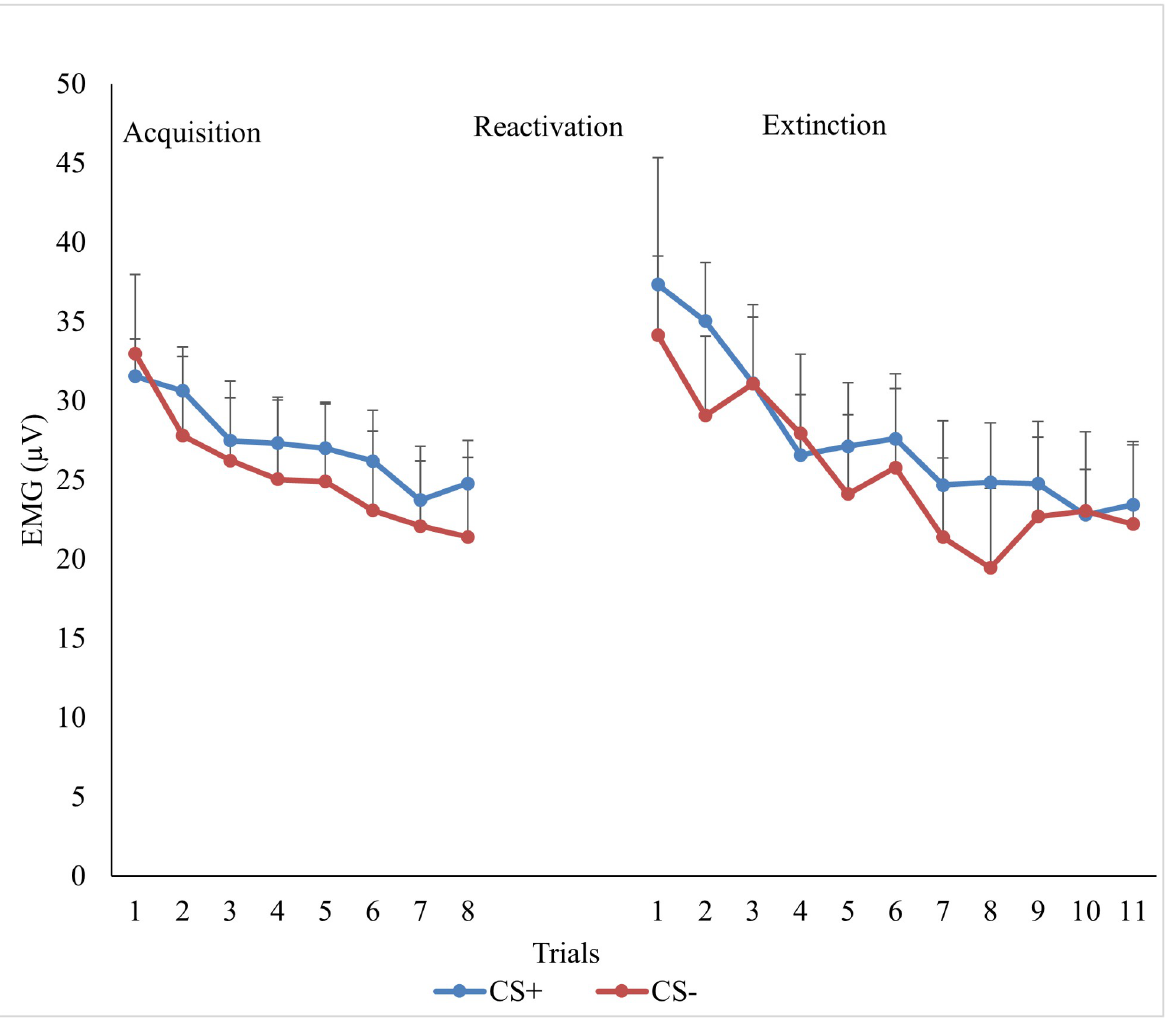
Fig 4. Mean FPS trial results for acquistion and extinction. Note . Mean fear potentiated startle (FPS) across trials collapsed across groups. Acquisition consisted of presentations of the CSa+ that was sometimes paired with the US and the CS- that was never paired with the US. FPS was not measured at reactivation so that fear response was not influenced by startle probe. Extinction consisted of the presentation of the CSa+ and the CS- without the US. The error bars represent standard error. Measures of FPS were taken at every presentation of a stimuli. # Note that EMG for the first CS+ trial is for the no reactivation group only. EMG was not measured during the reactivation trial for the other two groups as we did not want the startle probe to interfere with reconsolidation.